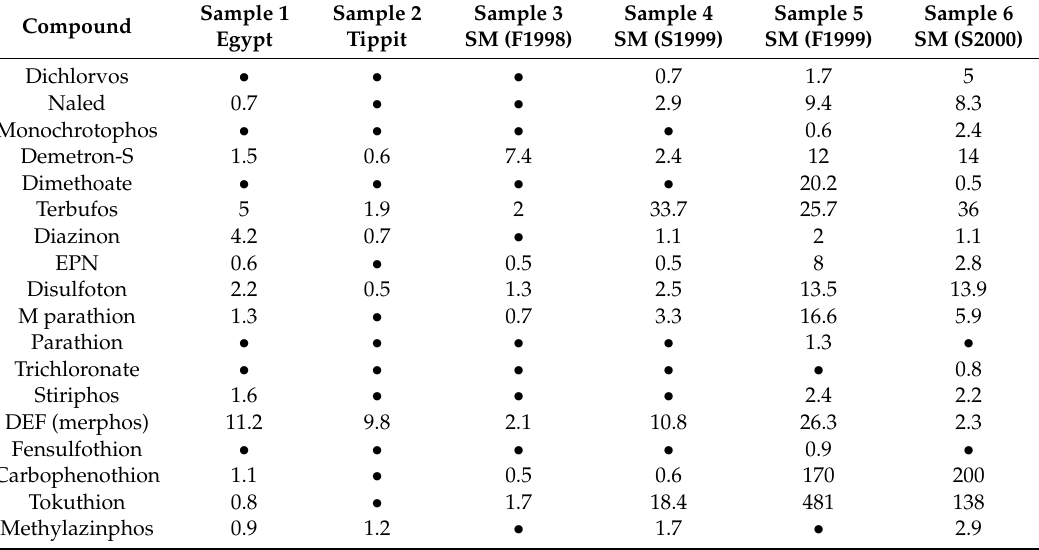
Table 3. Organophosphates (ppb) in guano from Shell Mountain, Egypt, and Tippit Caves. Dots represent non-reported numerical values that were either below minimum detection level, subject to interference, or not detected.